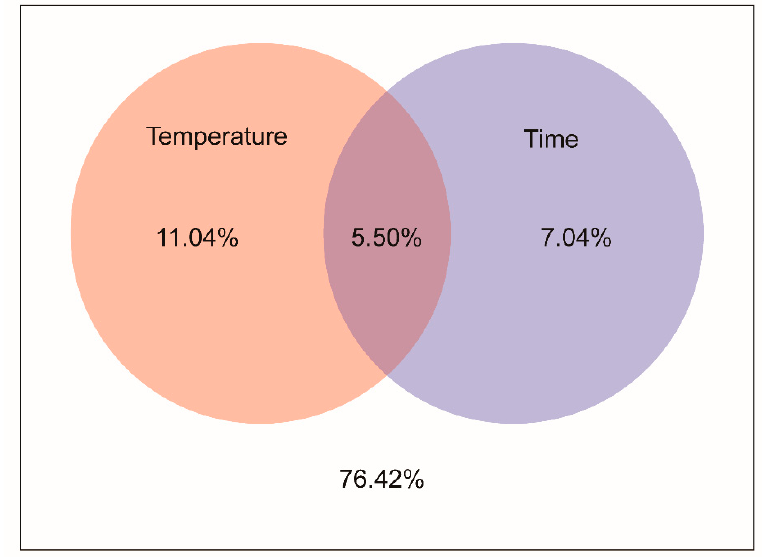
Figure 7. The VPA results. Description: the intersection of the circles is the explanatory quantity shared by the temperature factor and the time factor, and the area outside the circles is the unexplained quantity.